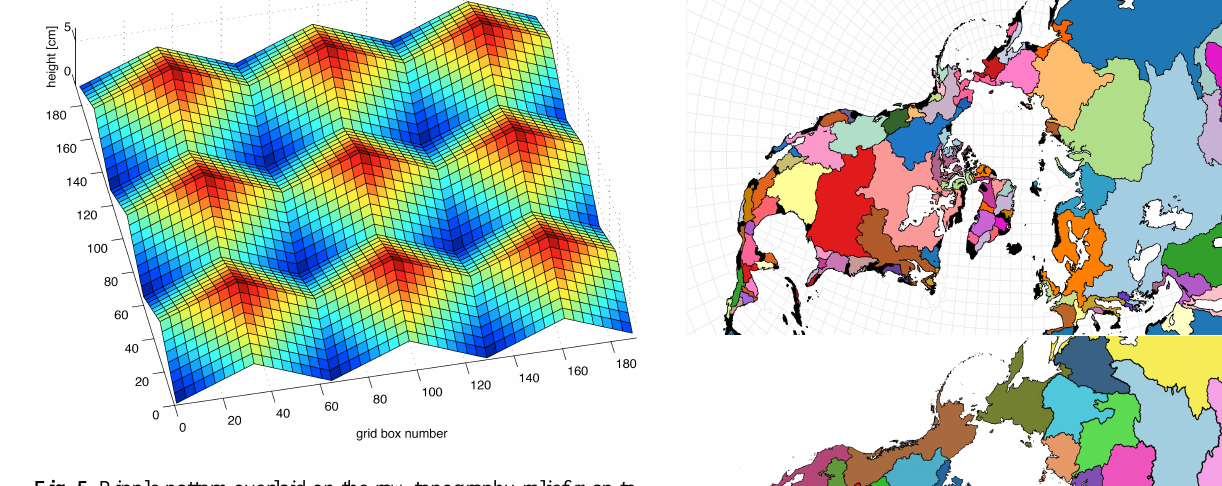
Fig. 5. Ripple pattern overlaid on the raw topography relief map to decrease computational costs in the solver in flat areas. The ripple depth of several centimetres is negligible compared to real topographic surface features.